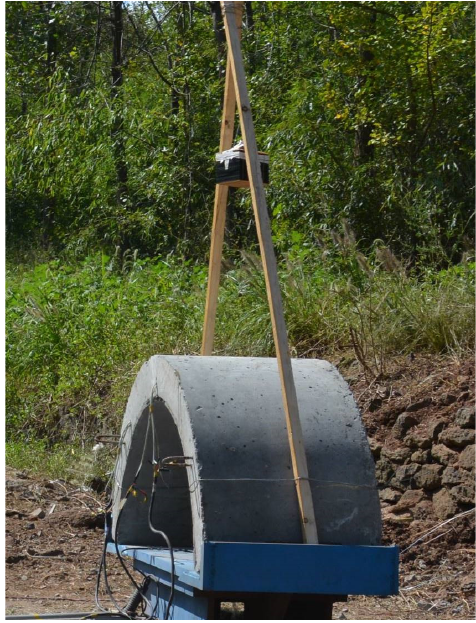
Figure 6. Anti-explosion experiment scheme of the arch structure.